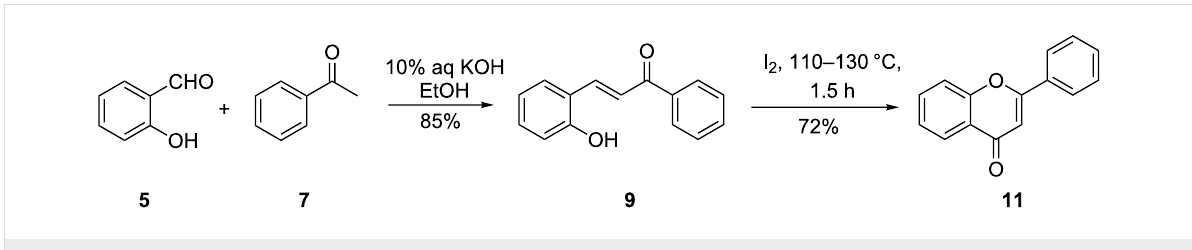
Scheme 5: Sashidhara and co-workers synthesis of flavone ( 11 ).